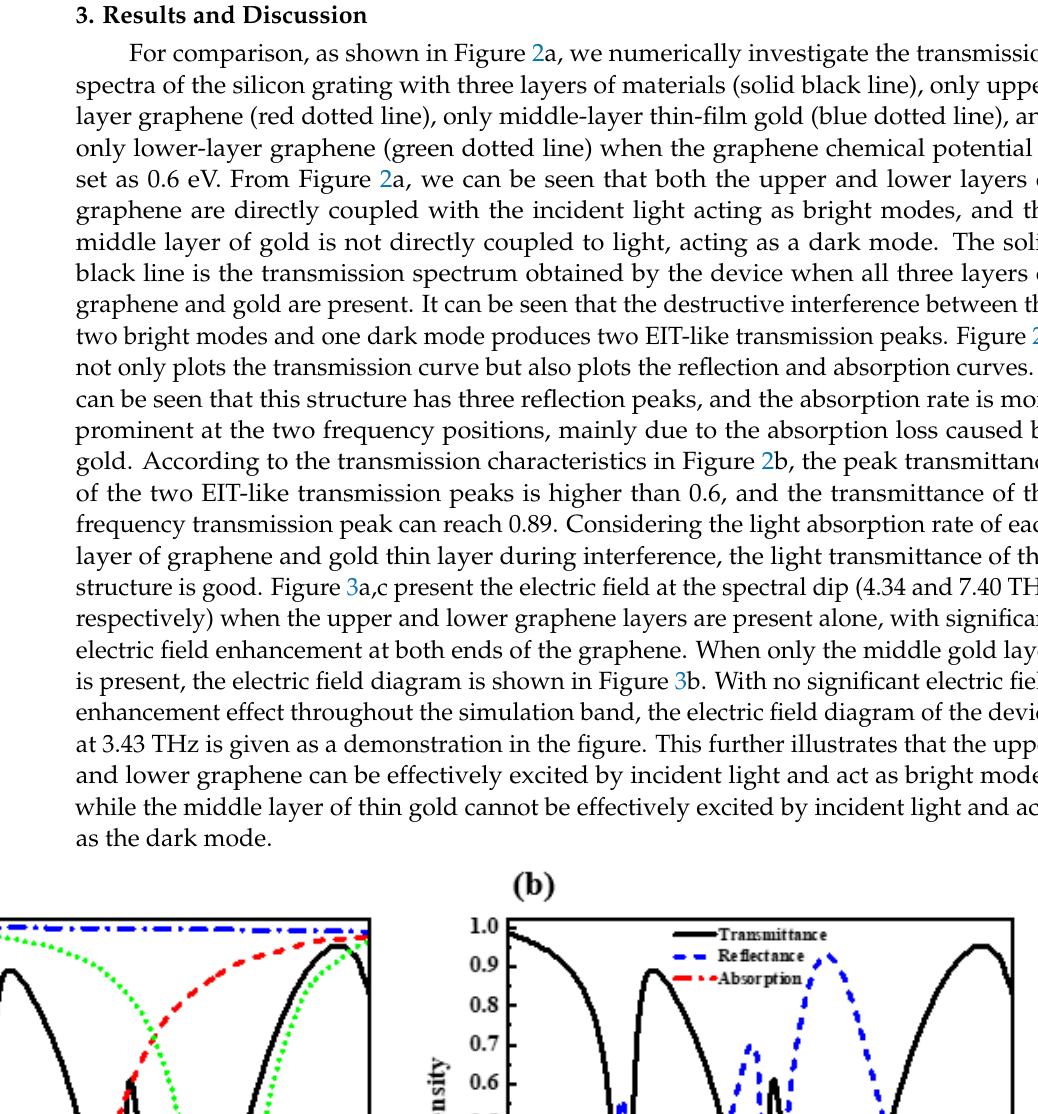
Figure 3. Distribution of the electric field when two layers of graphene and a thin layer of gold are present separately for this structure. ( a ) Upper layer graphene at resonant frequency. ( b ) Mid-layer of gold without resonance. ( c ) Lower layer graphene at the resonant frequency. The electric field distributions of the structure at the three dips and two peaks are given in Figure 4a–e. It can be seen that the first dip is generated by the destructive inter- ference between the upper-layer graphene and middle-layer gold, which can be under- stood as light–dark mode coupling, while the second and third ones are generated from the three layers of graphene and gold bright–dark mode coupling. In contrast, the lower- frequency peak is generated by the bright–dark mode coupling of the upper and middle layers of graphene and gold, and the higher-frequency peak is mainly caused by the bright mode of the lower layer of graphene.